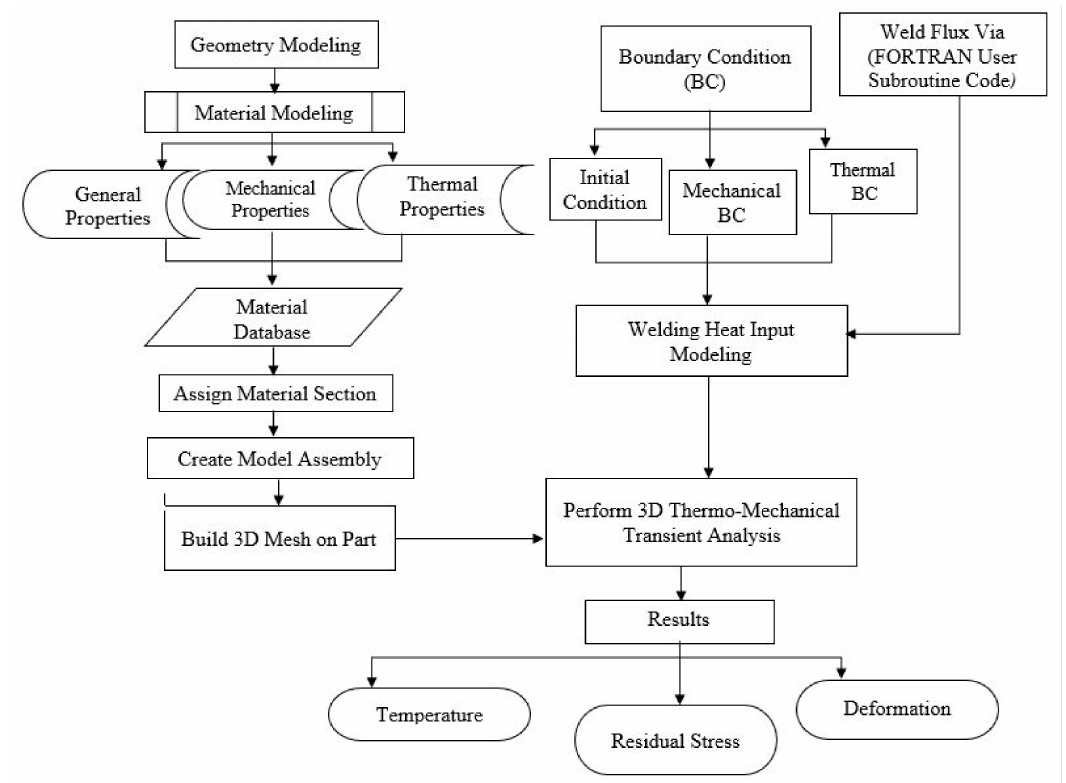
Figure 2. Finite element (FE) simulation